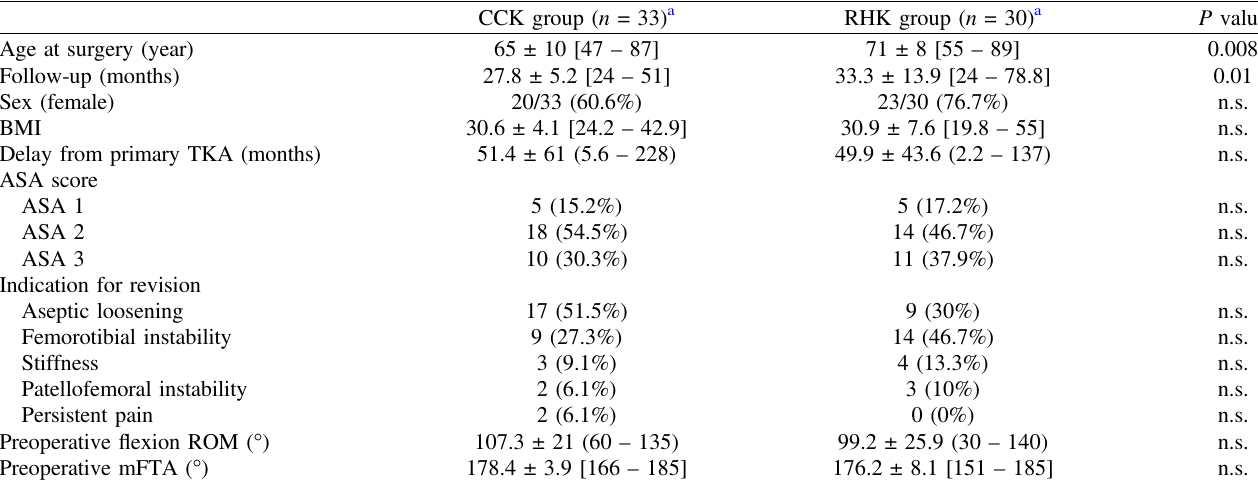
Table 1. Comparison of patient demographics by group.